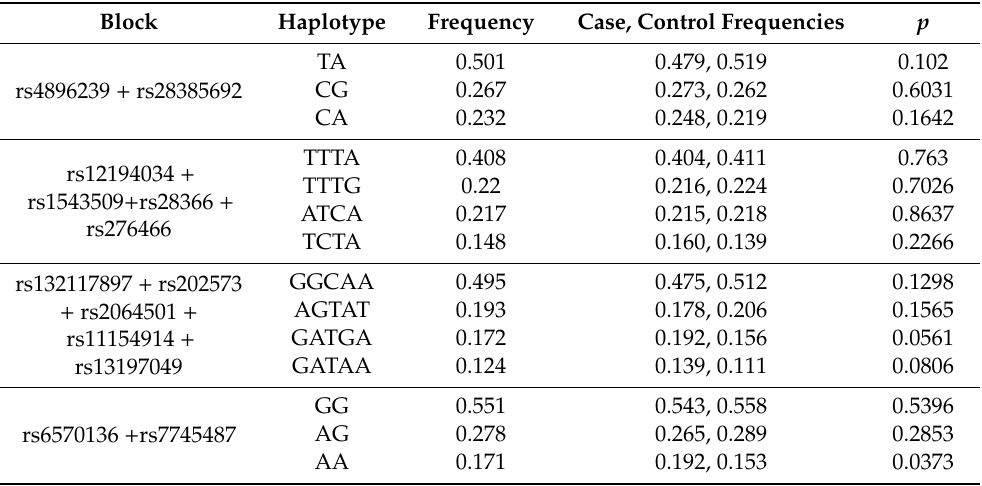
Table A2. Association values of the haplotypes in blocks. LD blocks were calculated with the confidence interval method using Haploview